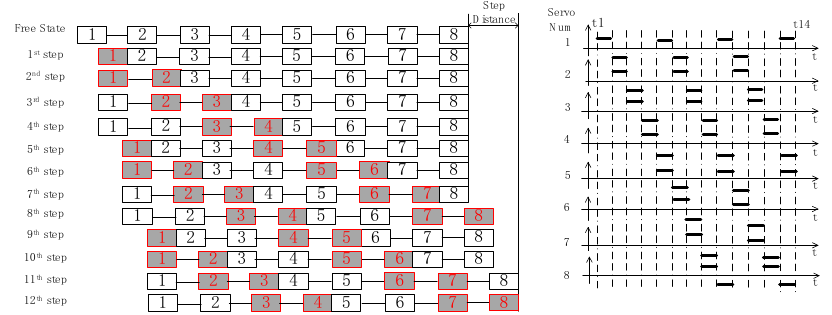
Figure 9. Multi-wave rectilinear movement gait and timing of the servo.